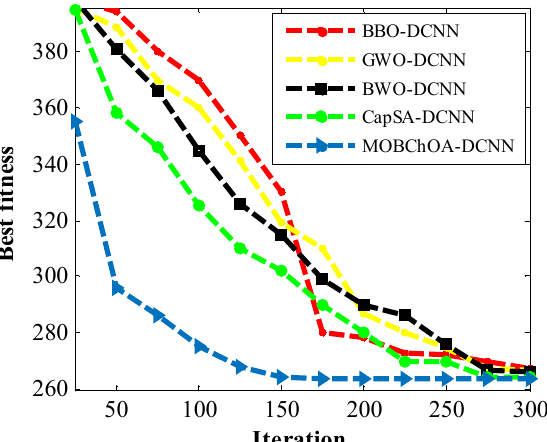
Figure 10. The convergence trends of the algorithms for the spring system problem.